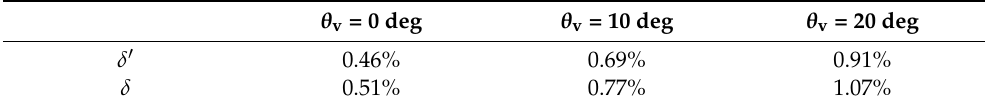
Table 3. Comparison of theory and the experiment.